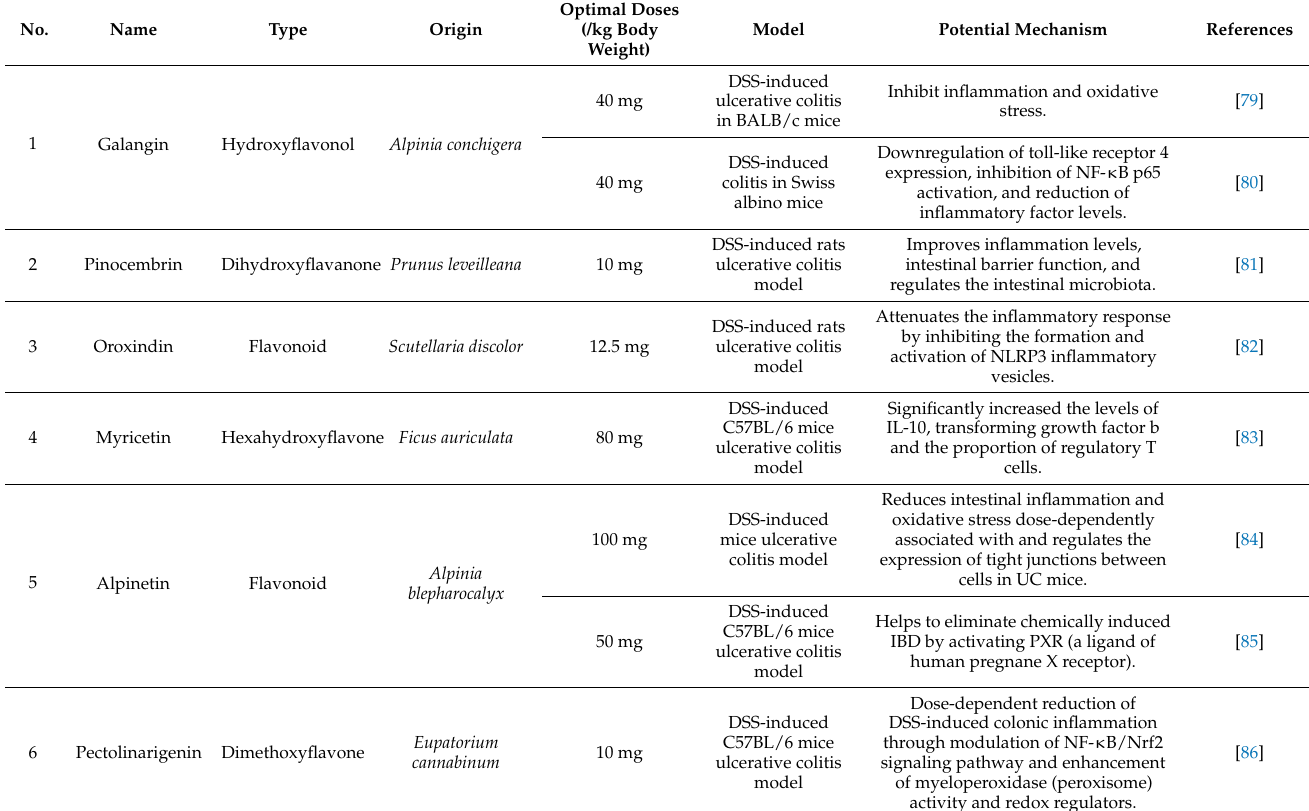
Table 1. In vivo therapeutic effects of flavonoids on experimental